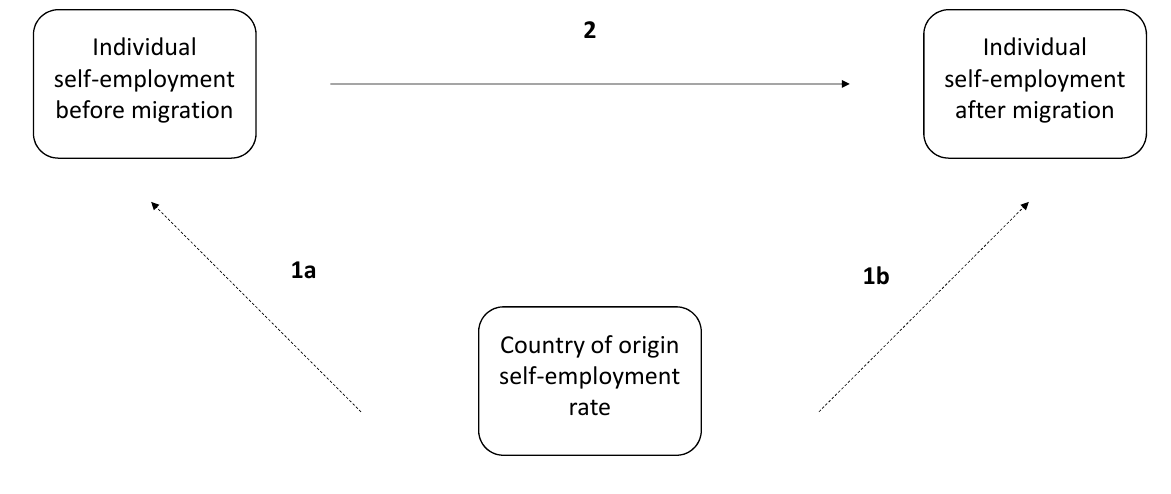
Figure 1: Home-country self-employment